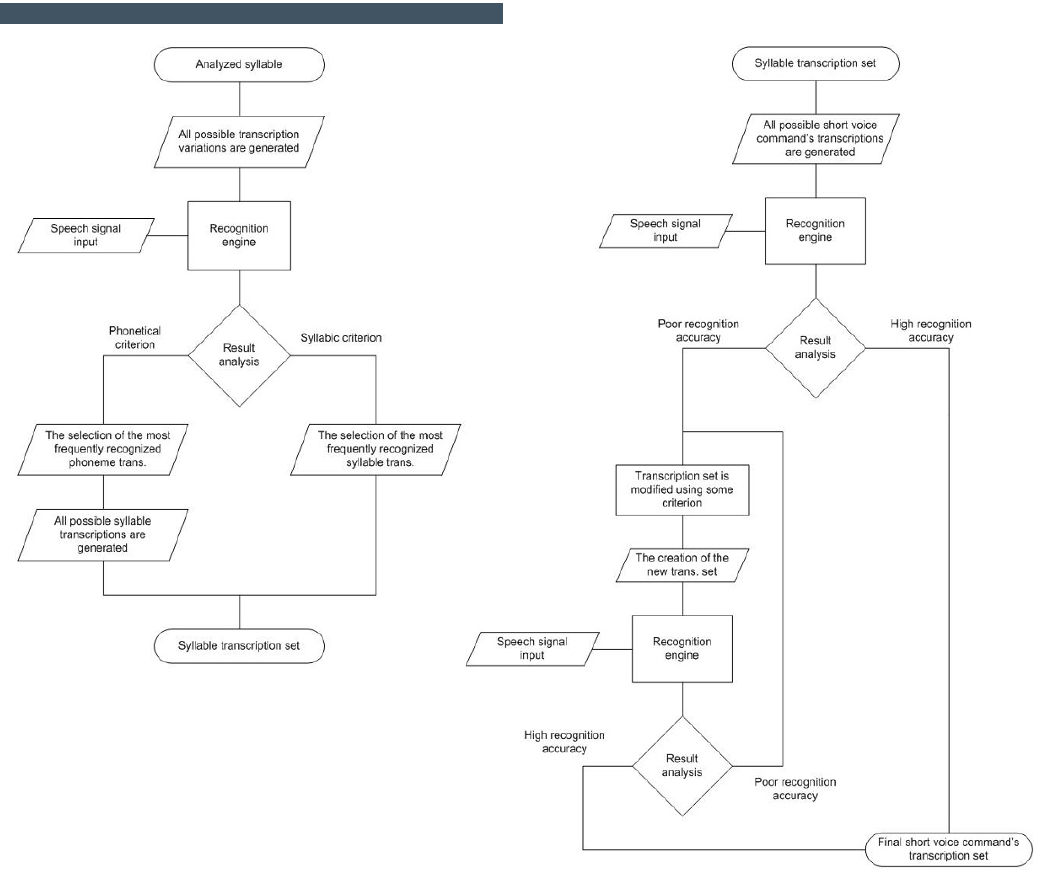
Figure 2. The algorithm for the: a) syllable transcription set creation; b) short voice command transcription set